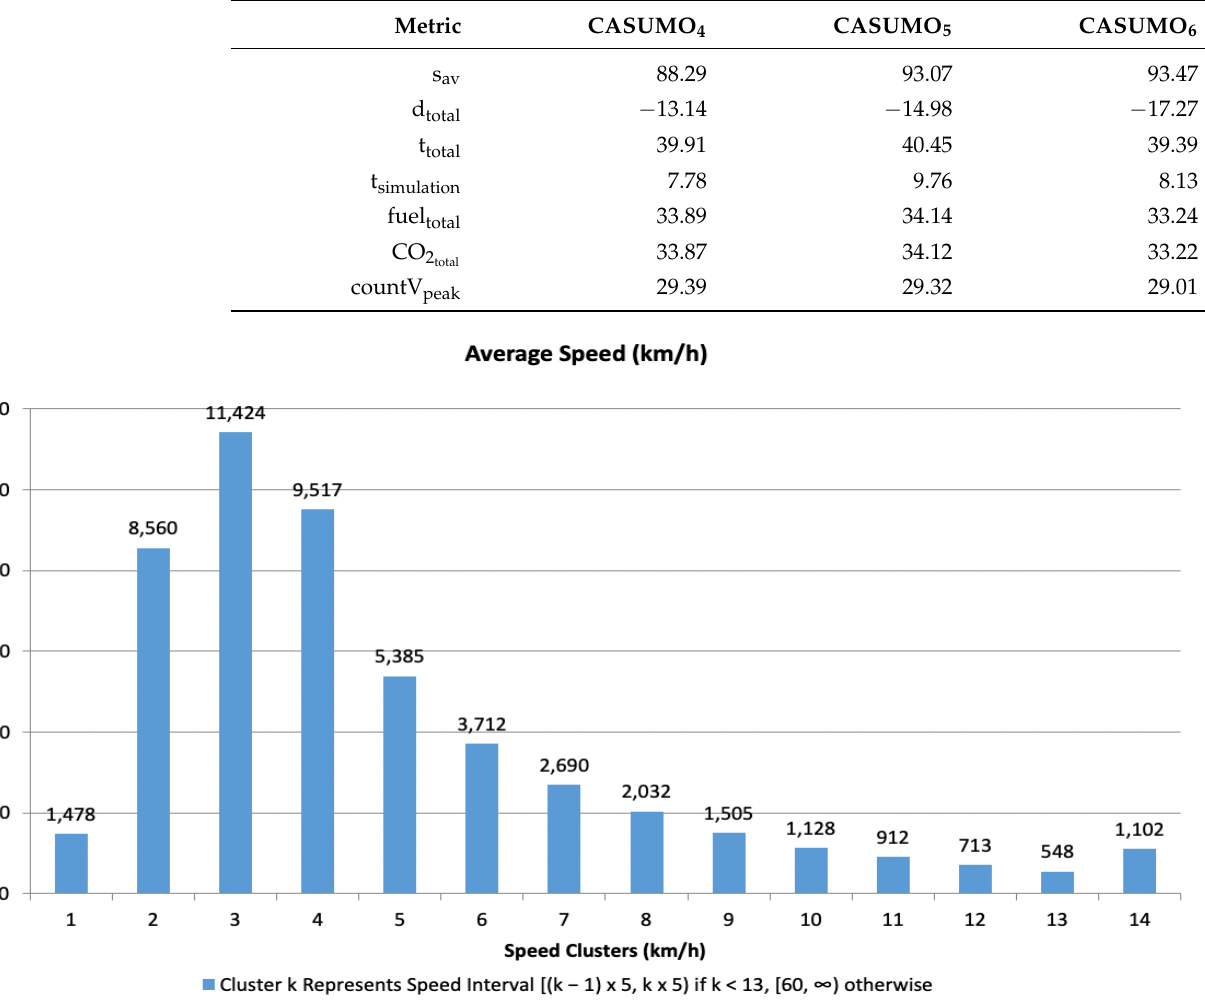
Table 5. Percentage improvement of the proposed solution for 50 K+ simulated vehicles in New York.